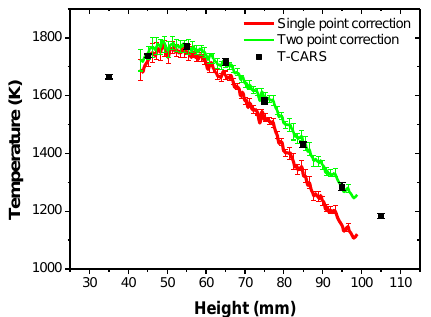
Figure 5. Temperature results of jet flame from PLIF and CARS.